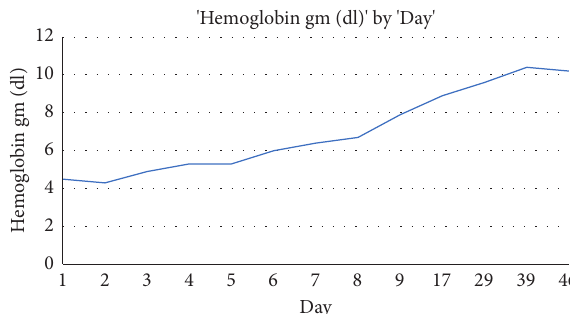
Figure 1: Hemoglobin trend during hospitalization and after